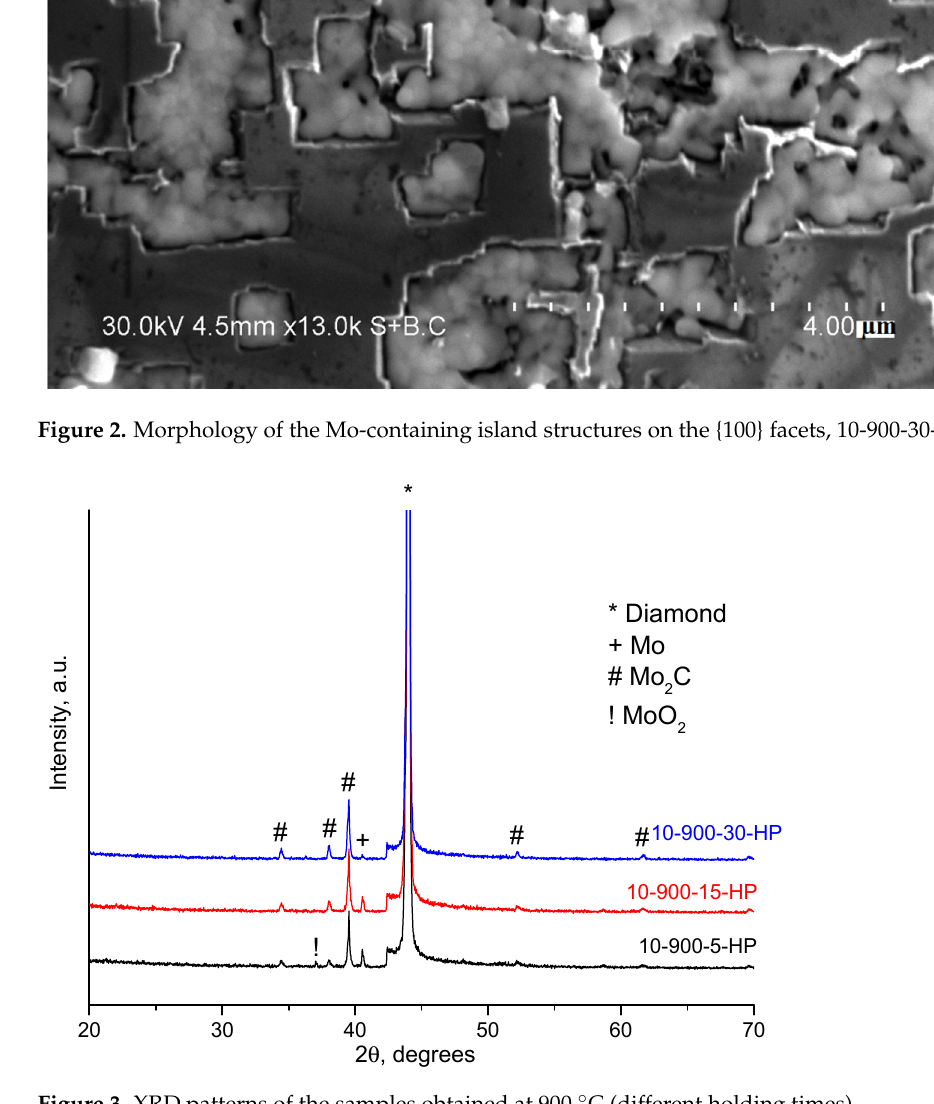
Figure 2. Morphology of the Mo-containing island structures on the {100} facets, 10-900-30-HP.